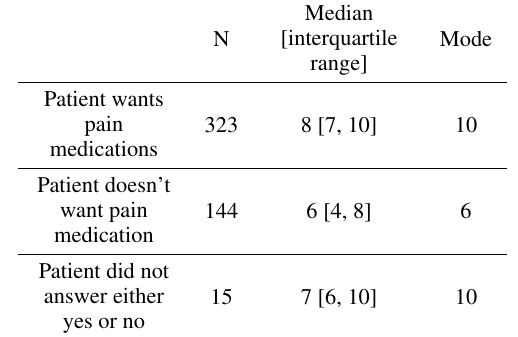
Table 2. Differences in triage pain score between patient desire for pain medications